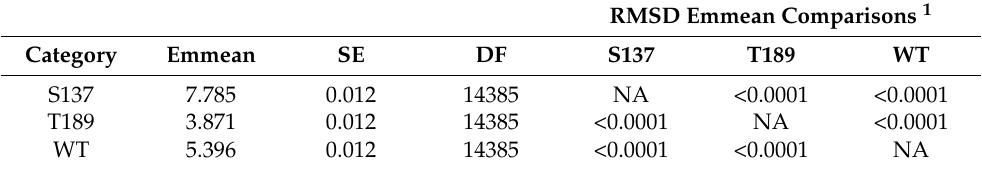
Table 2. Estimated marginal means (emmean) pairwise comparisons of the simulated structures RMSD (all residues).